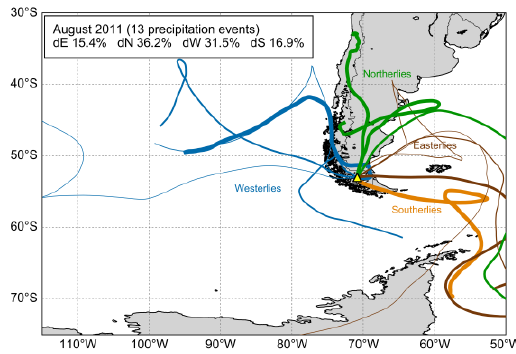
Figure 3. Visualization of GDAS-based precipitation-producing back-trajectories for an example month (August 2011). There are 13 precipitation events based on the 6 h precipitation data in this month. The total monthly precipitation amount is 26 mm. Trajectory paths that enter eastern, northern, western, and southern boundaries of Southern Patagonian landmass are grouped into clusters of distal easterlies (brown), northerlies (green), westerlies (blue), and southerlies (orange), respectively. The trajectory line width is proportional to the 6 h precipitation amount associated with each trajectory. For reference, the thickest and thinnest paths on this graph represent 4.6 mm and 0.2 mm precipitation, respectively. Yellow triangle marks Punta Arenas. The proportions of precipitation contributed by different trajectory clusters (easterly-derived—dE, northerly-derived—dN, westerly-derived—dW, and southerly-derived—dS) in that month can be calculated. This provides an additional metric that allows us to investigate if the proportion of precipitation derived from a certain trajectory cluster could influence monthly-composited δ 18 O p and d -excess in GNIP